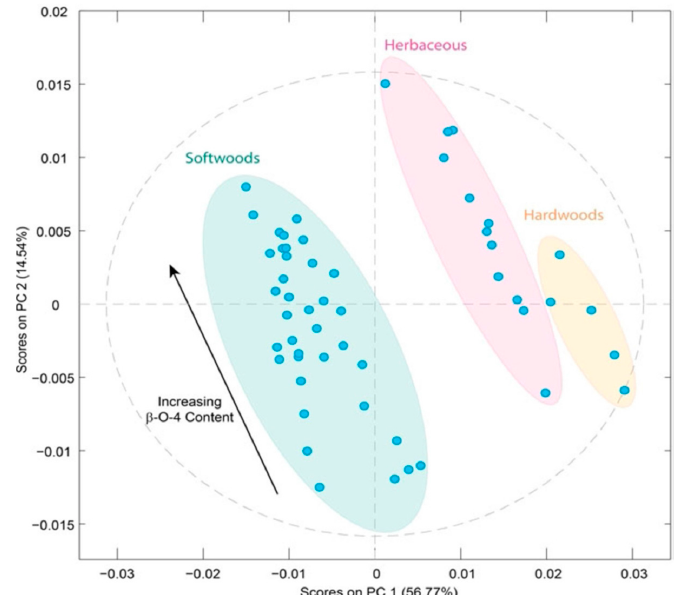
Figure 14. Principal component analysis plot of the 54 lignin samples used in this study. The FTIR spectra were pre-processed by applying baseline correction, 1st derivative transformation, normalization, and mean centering. Shading shows how the lignins are grouped according to their different botanical origins. The colored ellipses are intended for illustrative purposes only. Reproduced with permission from [131], Wiley-VCH 2019.